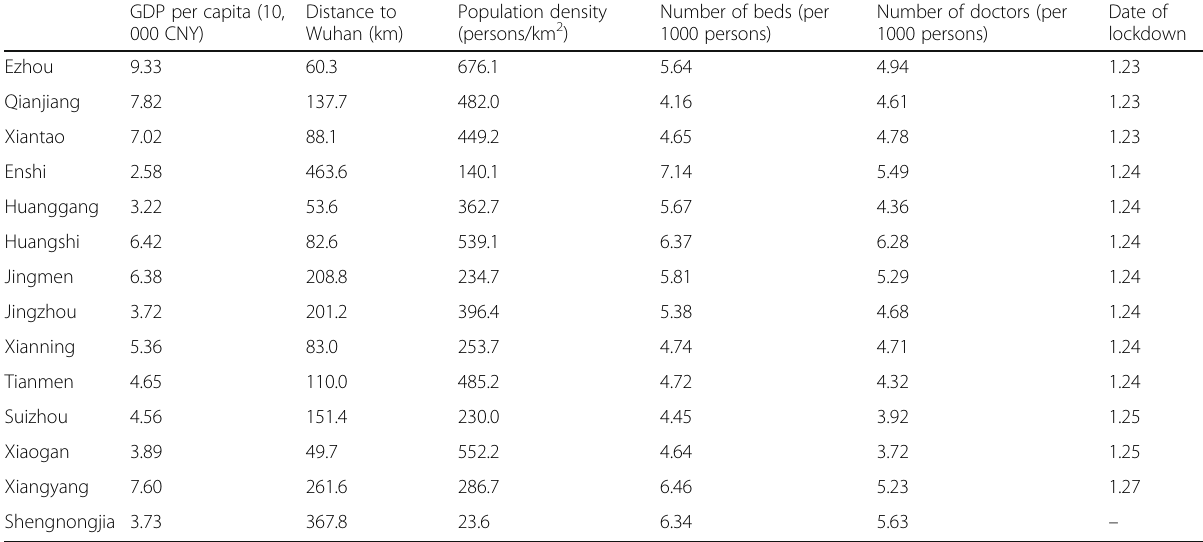
Table 4 Basic information of 16 prefecture-level cities in Hubei